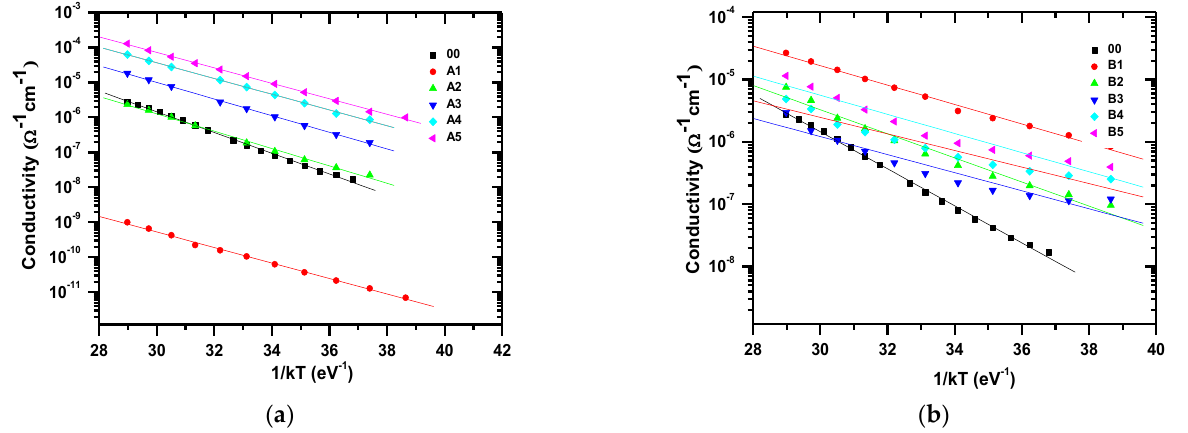
Figure 5. Relation between conductivity and 1/kT for two series of thin films: ( a ) n−type films with different H 2 and PH 3 contents; ( b ) p−type films with different H 2 and B 2 H 6 contents.